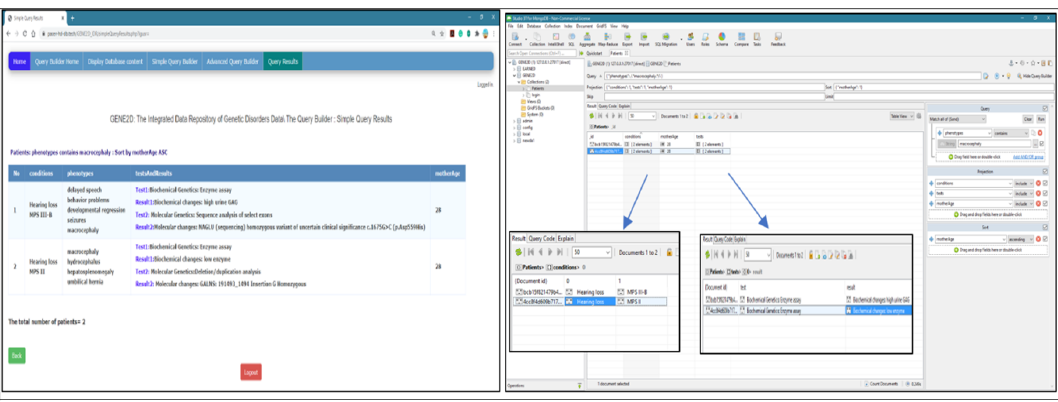
Figure 12. Testing query of the array type fields.